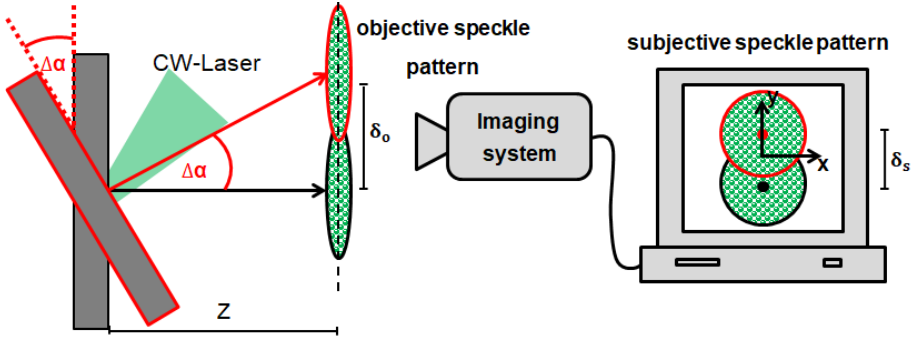
Figure 1. Speckle sensing theory: An object tilt results in a speckle pattern movement, which can be reconstructed with an imaging system. Figure after